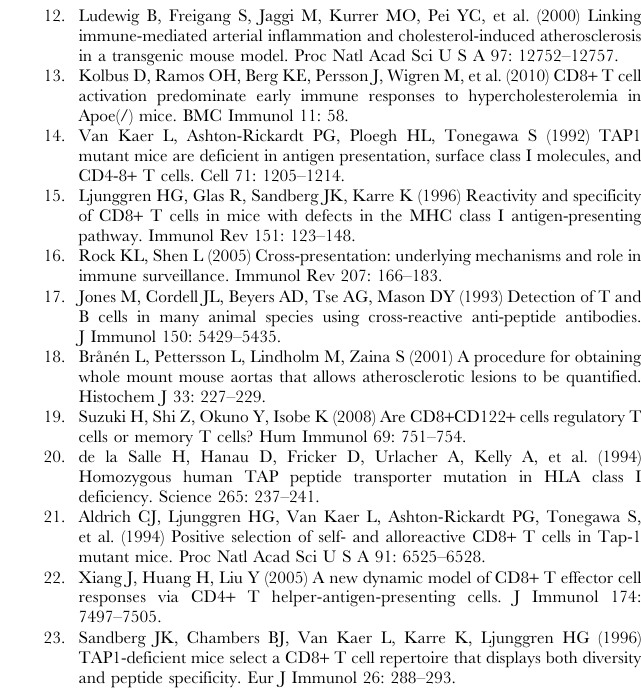
CD3 + CD4 + CD44 + CD62L 2 and (B) CD3 + CD8 + CD44 + CD62L 2 T cells in spleen and MeLN of Apoe 2 / 2 and Apoe 2 / 2 Tap1 2 / 2 mice. The cells were isolated from respective tissue, stained with fluorescent antibodies and analyzed by flow cytometry. Each dot in the figure represents one mouse. *** P , 0.001. (TIF) Figure S2 Regulatory CD8 + T cells in spleen and MeLN. Analysis of CD3 + CD8 + CD44 + CD62L + CD122 + T cells in Apoe 2 / 2 and Apoe 2 / 2 Tap1 2 / 2 mice in spleen and MeLN. The cells were isolated from respective tissue, stained with fluorescent antibodies and analyzed by flow cytometry. Each dot in the figure represents one mouse. ** P , 0.01, *** P , 0.001. (TIF) Figure S3 Regulatory CD4 + T cells in spleen and MeLN of young mice. Analysis of CD3 + CD4 + CD25 + FoxP3 + T cells in spleen and MeLN of Apoe 2 / 2 and Apoe 2 / 2 Tap1 2 / 2 mice given HFD for 8 weeks. The cells were isolated from respective tissue, stained with fluorescent antibodies and analyzed by flow cytometry. Each dot in the figure represents one mouse. ** P , 0.01. (TIF) Figure S4 ConA-stimulation of lymphocytes. Lympho- cytes from spleen and MeLN were incubated with ConA for 2 days and the relative fraction of CD4 + and CD8 + T cells was assessed by flow cytometry analysis. The CD8 + T cell fraction was larger than the CD4 + T cell fraction in spleen and MeLN of both Apoe 2 / 2 and Apoe 2 / 2 Tap1 2 / 2 mice. ** P , 0.01, *** P , 0.001.